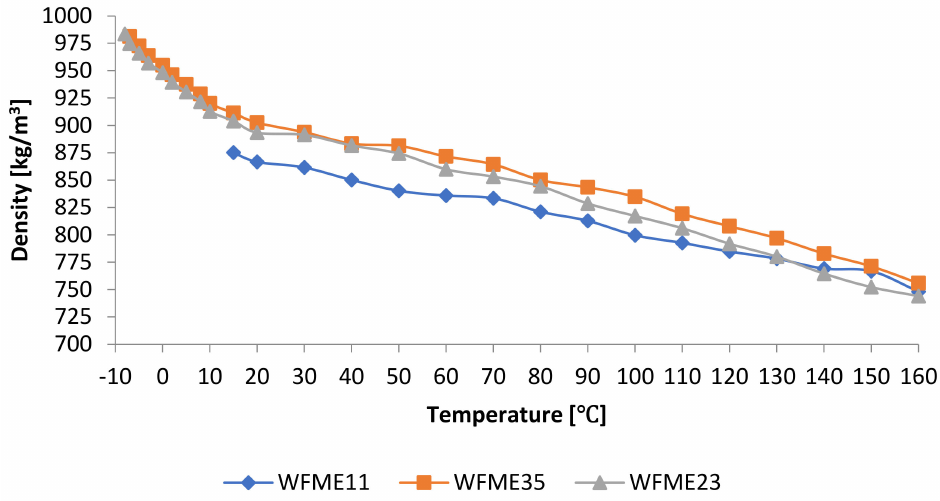
Figure 3. Density – Temperature relationship for selected biodiesel